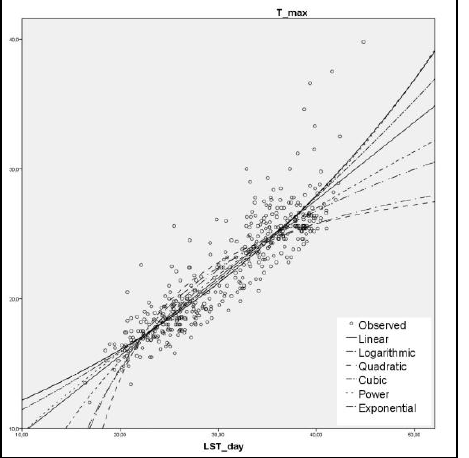
Figure 3. Correlation graph between Daytime MODIS LST and T max